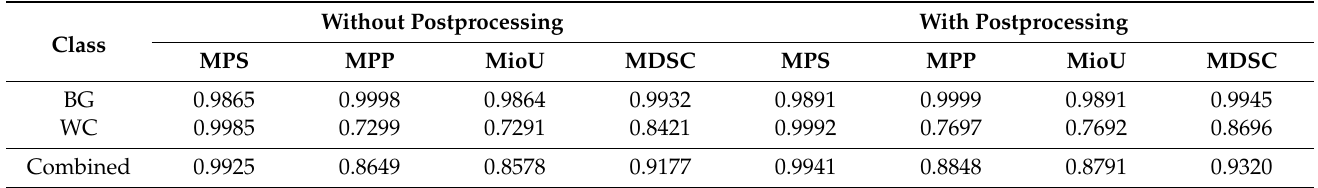
Table 3. Water channel segmentation performance by the proposed